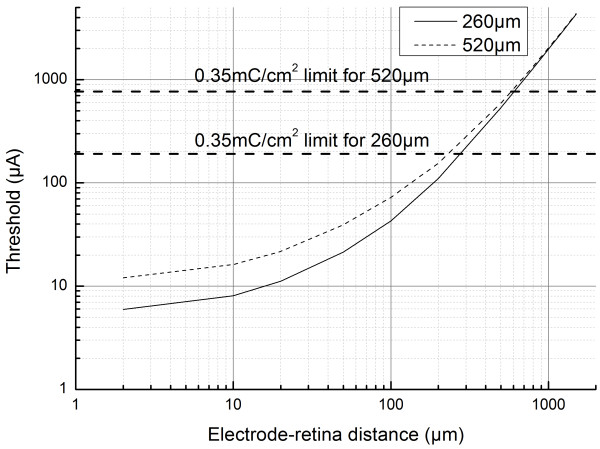
Threshold current versus electrode-retina distance. Evolution of computed threshold current with variation in electrode-retina distance for two electrode sizes (260 μm and 520 μm). We observe that there is a factor two difference of threshold between the two sizes when the electrode is in contact with the retina. Approximately, an order of magnitude increase in threshold current is observed when the electrode-retina distance reaches half of the electrode diameter. When electrode-retina distance exceeds the electrode diameter, the threshold current becomes proportional to the square of the distance. The corresponding charge injection limit (for 0.975 ms pulses) is displayed for both electrode sizes.